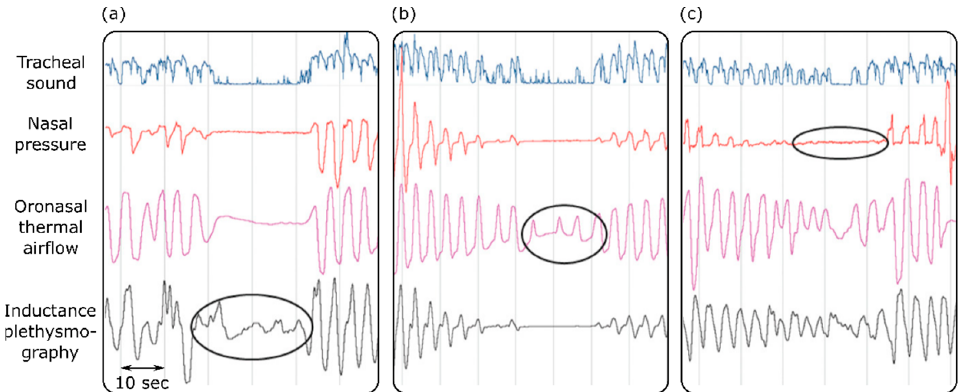
Figure 3. Detecting sleep apnea using tracheal sounds, nasal pressure, oronasal thermal airflow, and inductance plethysmography. Apnea is not detected by inductance plethysmography or the oronasal thermal airflow sensor in ( a , b ). Oral breathing is mistaken for apnea by the nasal pressure transducer ( c ). Adapted from ref. [118].